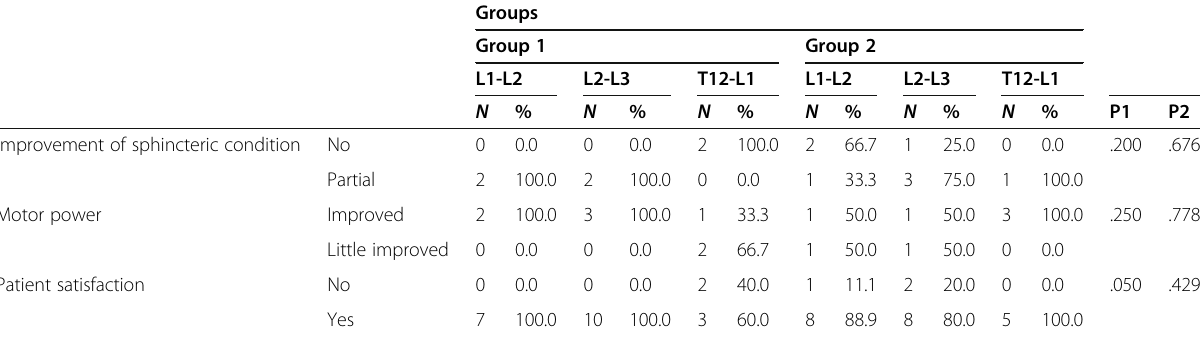
Table 5 Lumbar disc level and surgical outcome groups